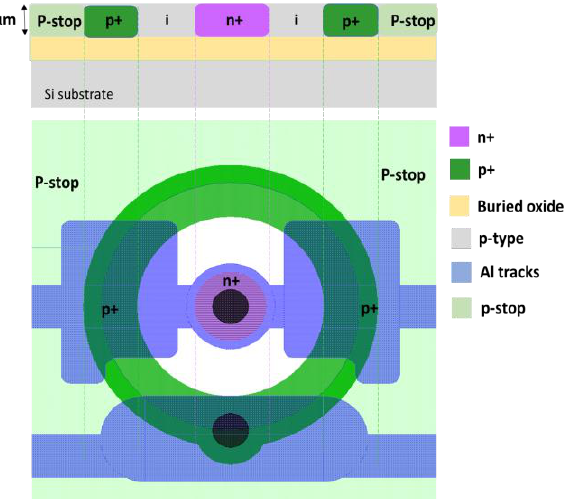
Figure 1. Cross-sectional and top-view schematic of the planar structure of the microdosimeter.